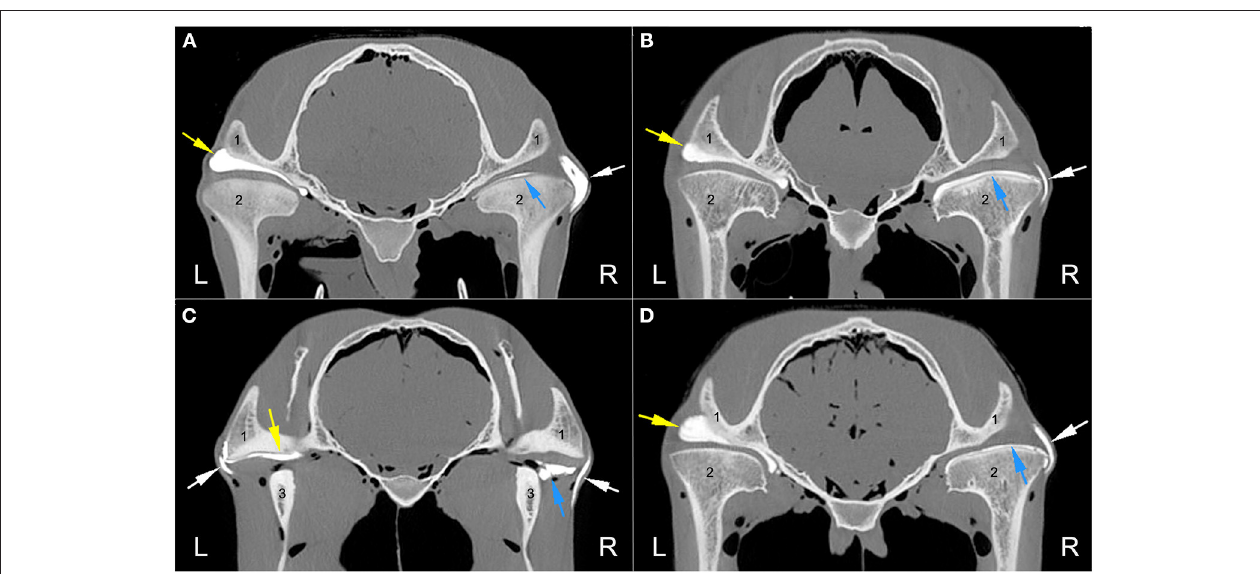
FIGURE 1 | Axial computed tomography arthrography images at the level of the temporomandibular joint (TMJ) of four different heads illustrating the varying degrees of contrast extravasation. (A) No contrast is present outside of the left TMJ in comparison to the large amount present on the right side. (B) No contrast leakage from the left TMJ with mild to moderate amounts present on the right side. (C) Mild amount of left TMJ leakage and a mild to moderate amount on the right side. (D) No contrast is present outside the left TMJ with mild to moderate amounts on the right side. Arrows indicate the presence of the radiopaque contrast material in the discotemporal joint (yellow), discomandibular joint (blue), and varying amounts outside the joints (white). L, left; R, right. 1, zygomatic process of the temporal bone; 2, mandibular condyle; 3, ramus of the